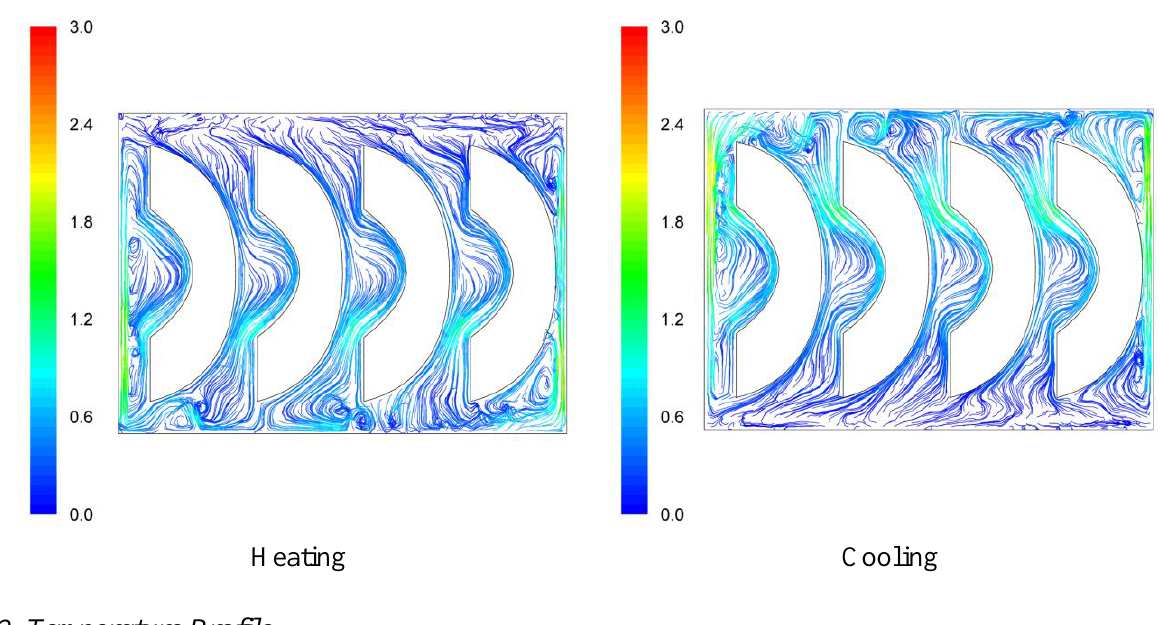
Figure 5. Velocity pathlines after 30 s of heating (left) and after 30 s of cooling (right) for the “sideward” case (velocity in